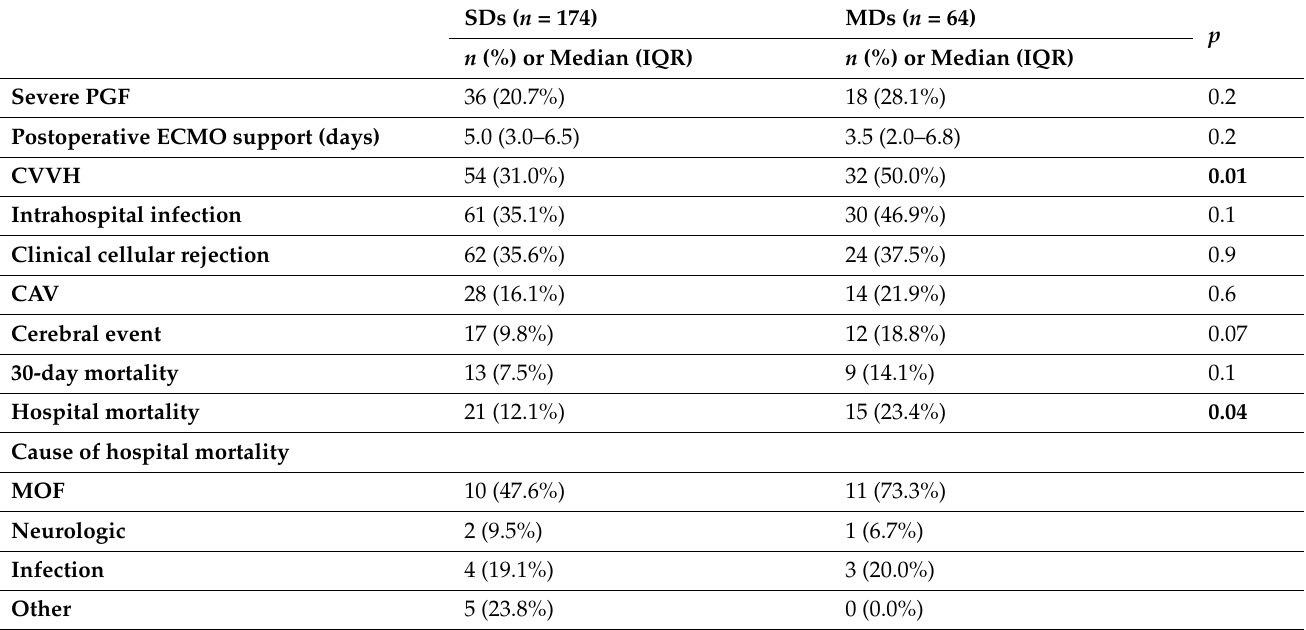
Table 3. Outcomes and complications of organ recipients from standard versus marginal